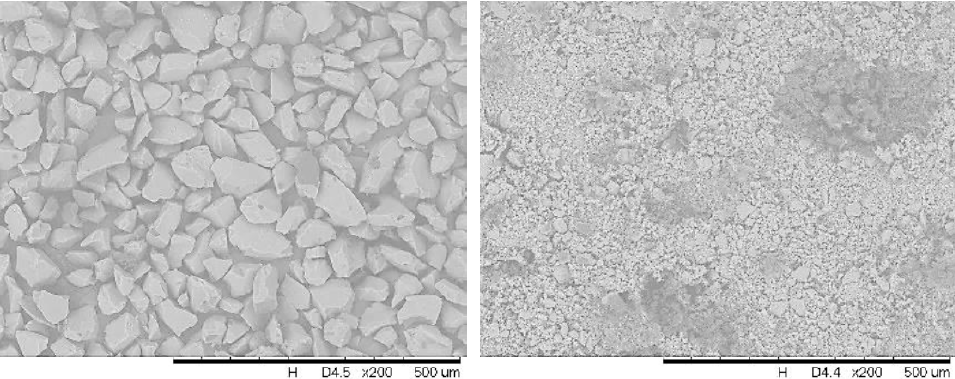
Figure 5. SEM analysis of support (SiCl) and NHPI immobilized on chloropropyl silica gel (SiOCONHPI).